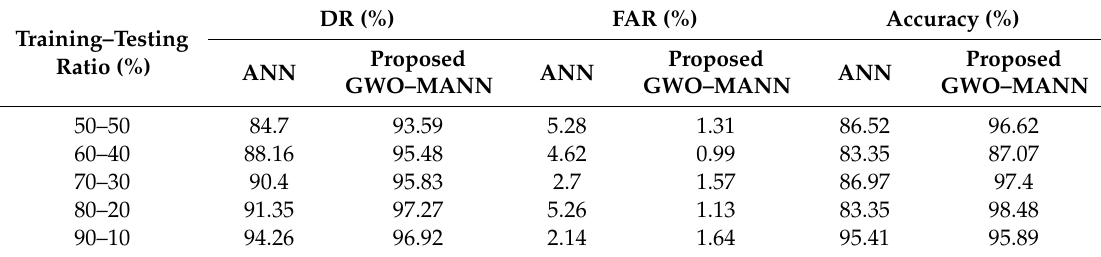
Detection rate, false alarm rate and accuracy values of the proposed gray wolf optimization-based modified artificial neural network (GWO–MANN) and an existing artificial neural network (ANN) for varying training–testing